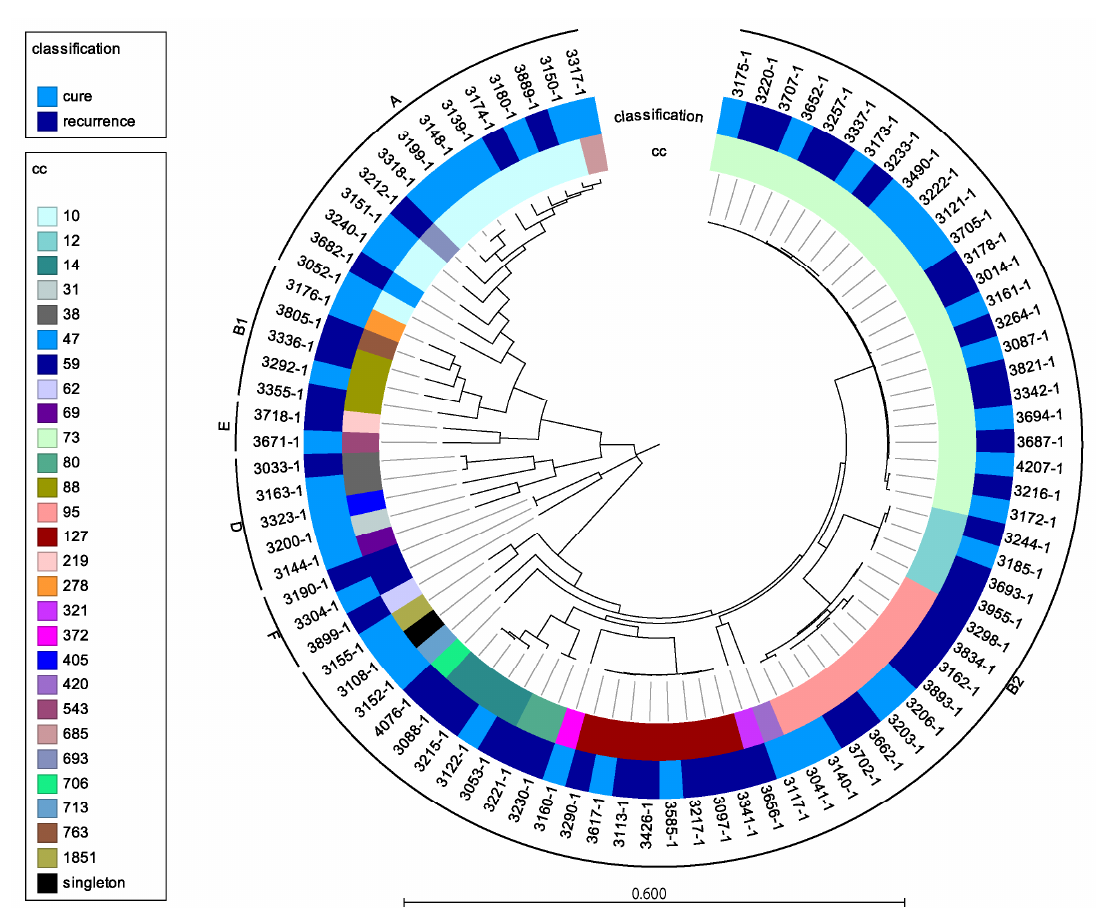
Figure 3. Midpoint-rooted phylogenetic clustering of recurrent and non-recurrent E. coli . Phylogenetic groups are illustrated along the periphery of the tree. Scale bar: substitutions/site. CC: clonal complexes based on MLST